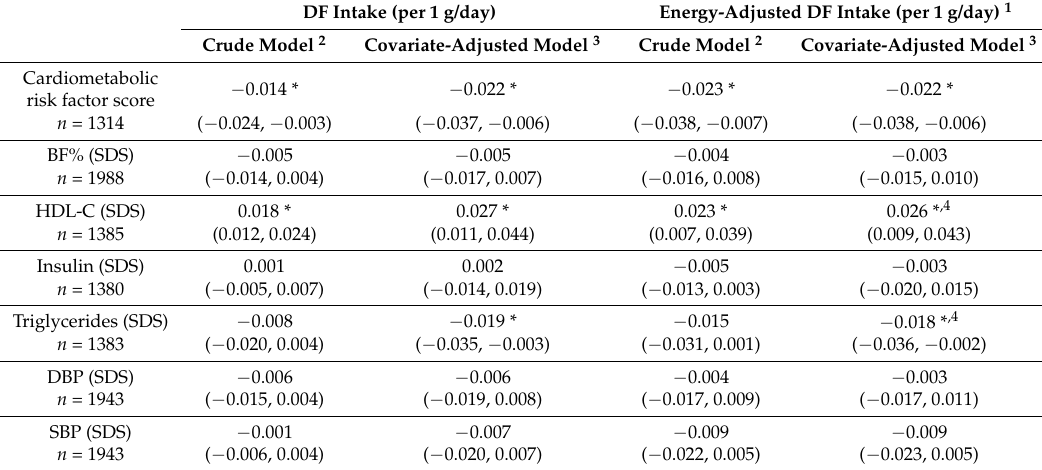
Table 2. Crude and covariate-adjusted associations between DF intake and energy-adjusted DF intake and cardiometabolic